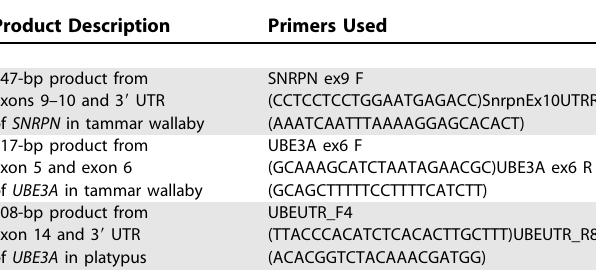
Table 3. PCR Products Used in Expression Studies Product